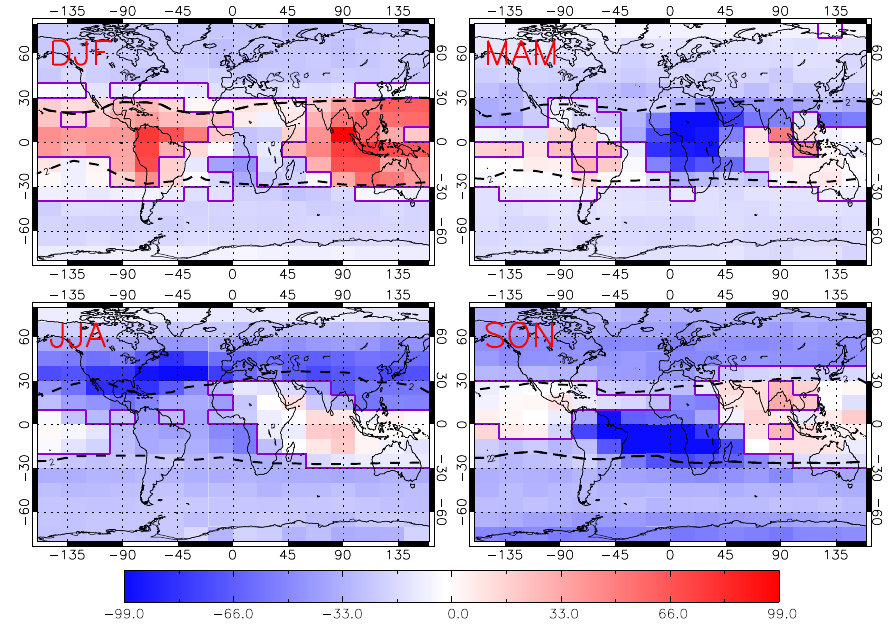
Figure 12. Difference in PAN (pptv) between the TOMCAT model (with IMK AKs applied) and observed IMK MIPAS PAN at 150hPa for 2007–2008 in DJF, MAM, JJA, and SON. Purple polygon areas show regions of significant differences, where the | TOMCAT − observations | > observational error.